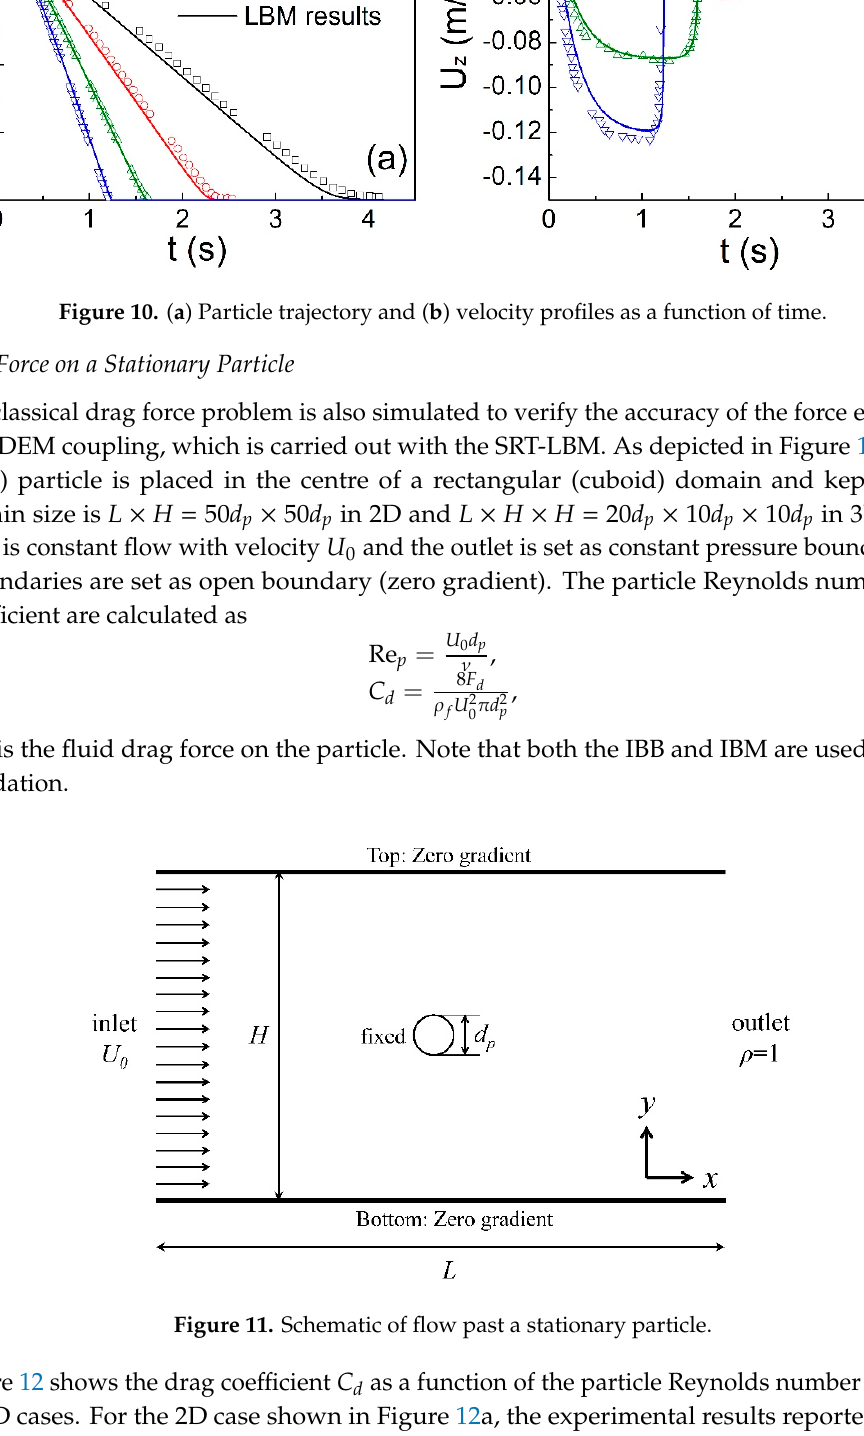
Figure 11. Schematic of flow past a stationary particle.